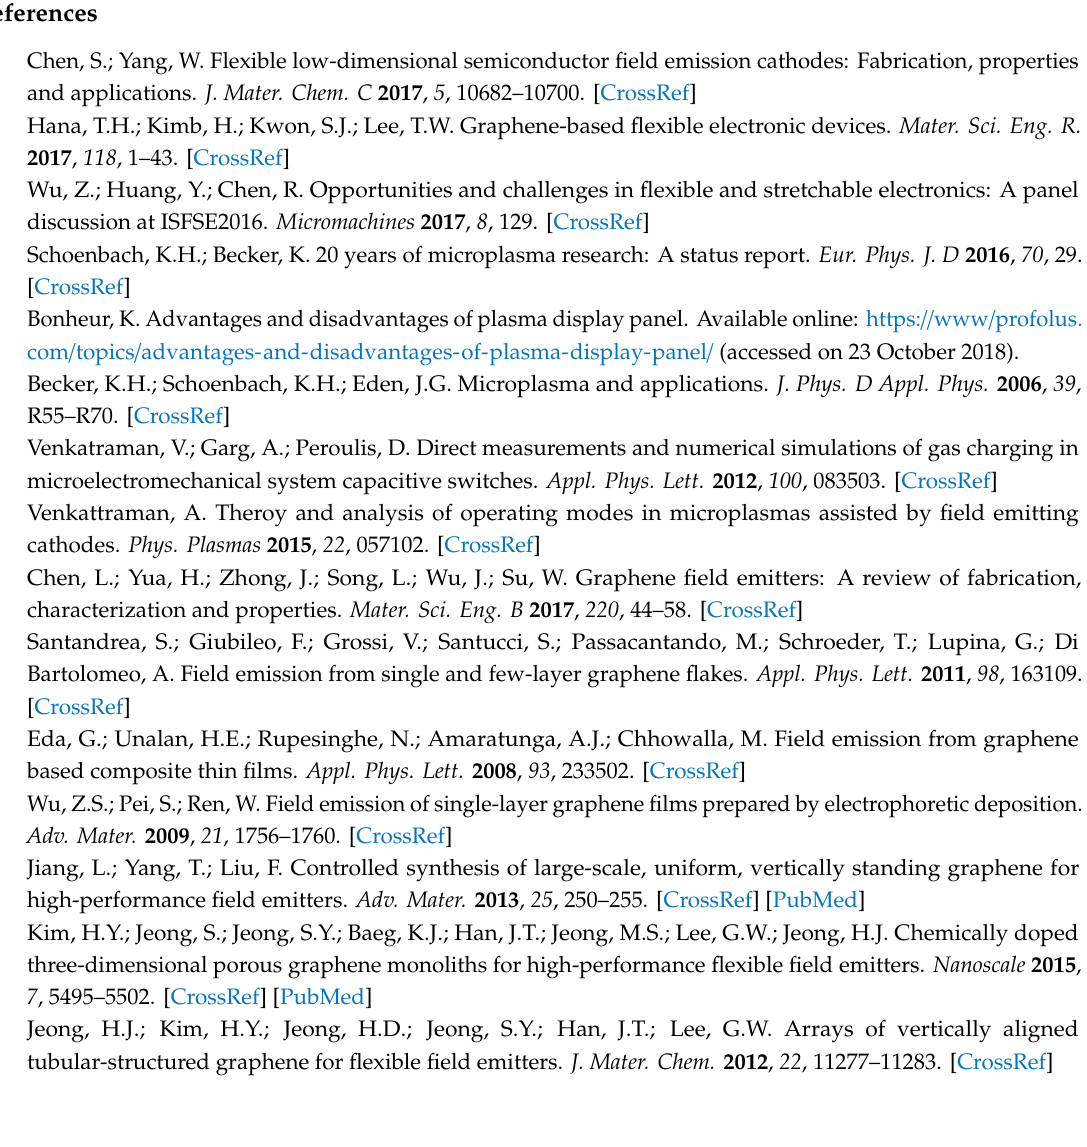
Figure S1: FESEM micrographs of the LIGNs. Figure S2: ( a ) The X-ray photoelectron spectroscopic (PHI 6000; Al K α radiation with an energy of 1486.6 eV and an energy resolution of 0.47 eV) survey spectrum shows a dominant carbon peak and a small oxygen peak of 96.3 at.% and 3.7 at.%, respectively, along with ( b ) the C1s and ( c ) O1s XPS spectra of the LIGNs. Figure S3: ( a ) Surface topography and ( b ) work function map of the LIGNs. Figure S4: Photograph of the homemade PI